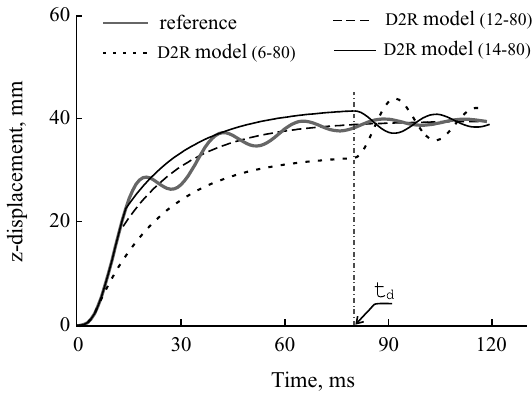
Fig. 4. Comparison of vertical displacement of the suspended mass for various D2R switch timings. The numbers in the parenthesis denote t r and t d respectively in this figure and subsequent